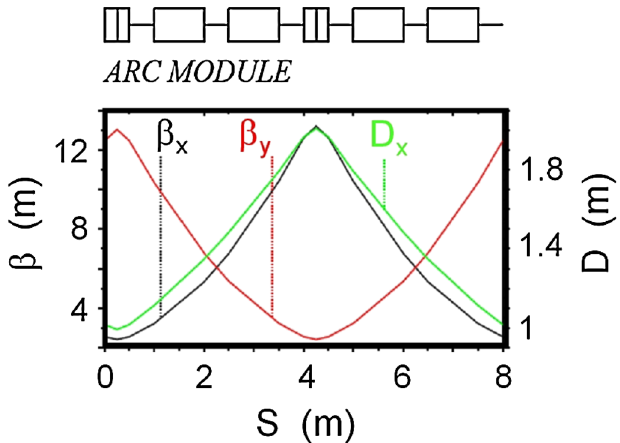
FIG. 15. (Color) Optical functions ð (cid:6) x ; (cid:6) y ; D x Þ for the perma- nent magnet arc cell, which consists of four 1 m dipoles and two 0.5 m quadrupoles, with 0.5 m spacing between magnets. The magnets would have an aperture of (cid:2) 0 : 15 m